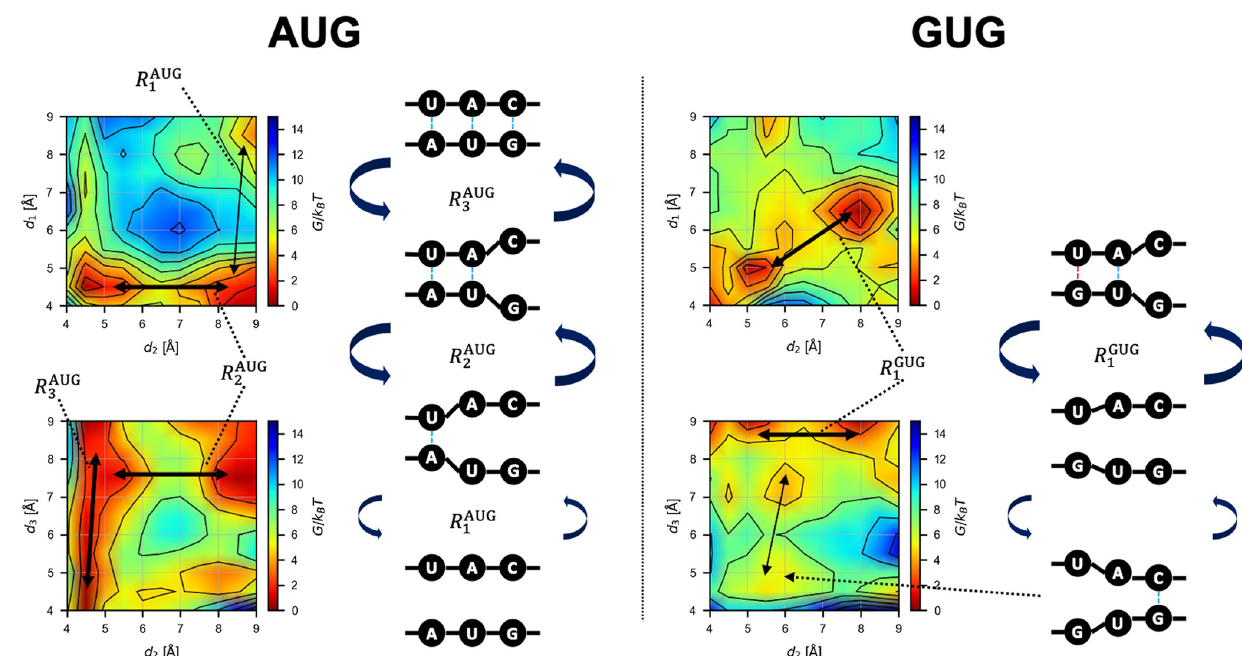
Fig 6. Schematics of the base-pair binding dynamics. Conformational changes inferred from the free energy landscape (Fig 5). The transition path R � AUG or GUG) is shown by black arrows (thick arrow: frequent transition; thin arrow: less frequent transition). Blue and red dotted lines indicate Watson- Crick or wobble base-pairing, respectively. In left, AUG pairing is described as being stabilized by the first position. Subsequently, the binding propagates into the second and the third position. In right, GUG pairing is described as bistable states; the base-pairing between GU and the corresponding bases in the anticodon, and the base pairing between the 3rd G and the C residue of the anticodon. Thus, a complete base-triplet interaction is unstable.